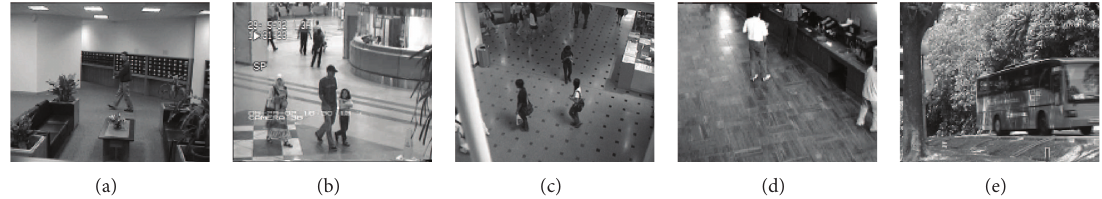
Figure 1: Test samples from video sequence: lobby (a), airport (b), shopping mall (c), restaurant (d), and campus (e).